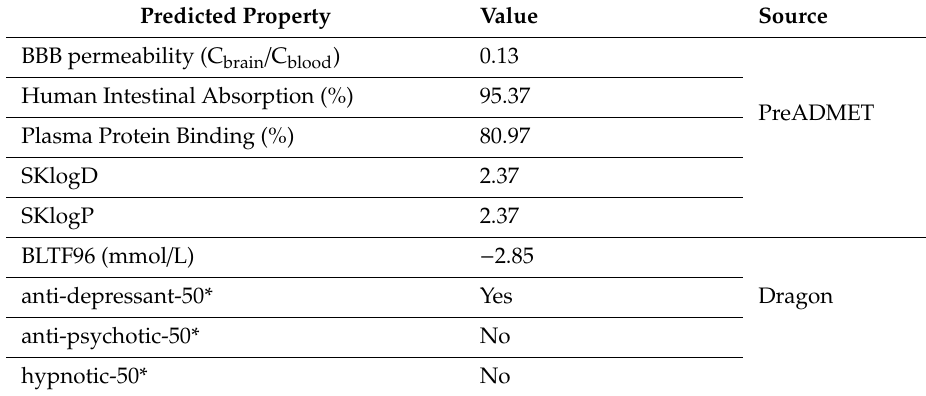
No * For the explanation of the parameters see